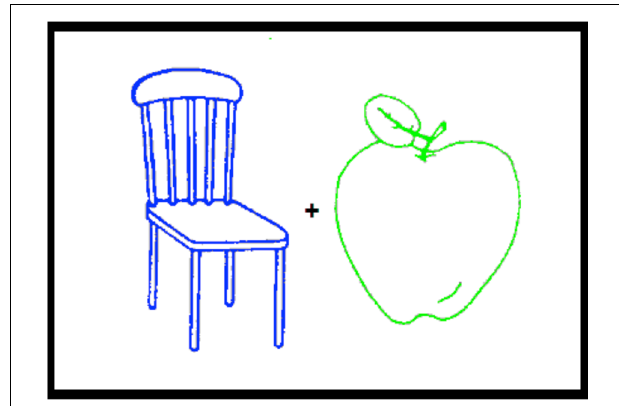
FIGURE 1 |An example of the two picture outlines, one green and the other blue, presented during the encoding phase of Experiments 1 and